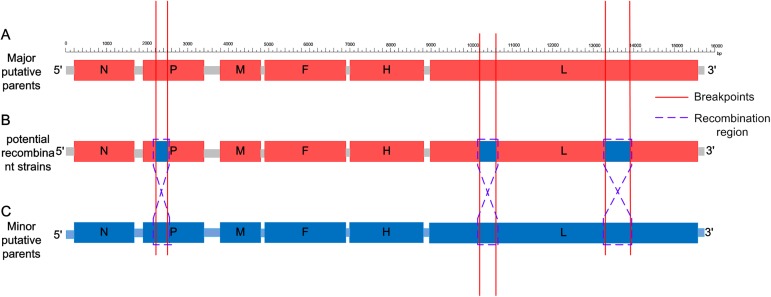
A schematic map of the genome for the recombinant strains of CDV.(A) Major putative parents for recombinant strains. (B) Potential recombinant strains of CDV. (C) Minor putative parents for recombinant strains. The same breakpoints in different genome schematics were labeled with a red line, and the recombinant fragments were labeled with a blue dotted line. The x-axis indicated the nucleotide position along the alignment (gap 100 bp).